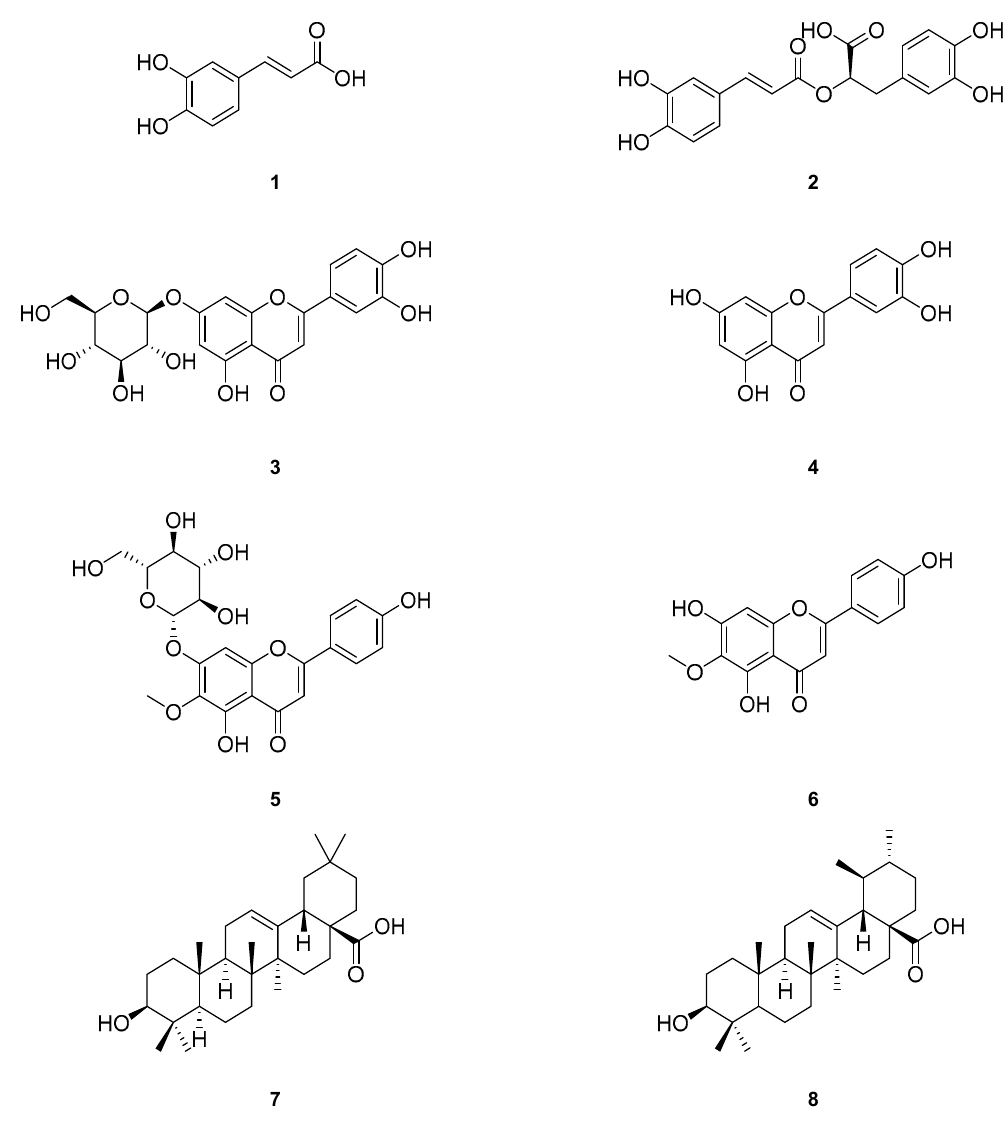
Figure 2. Chemical structures of the isolated compounds ( 1 – 8 ).